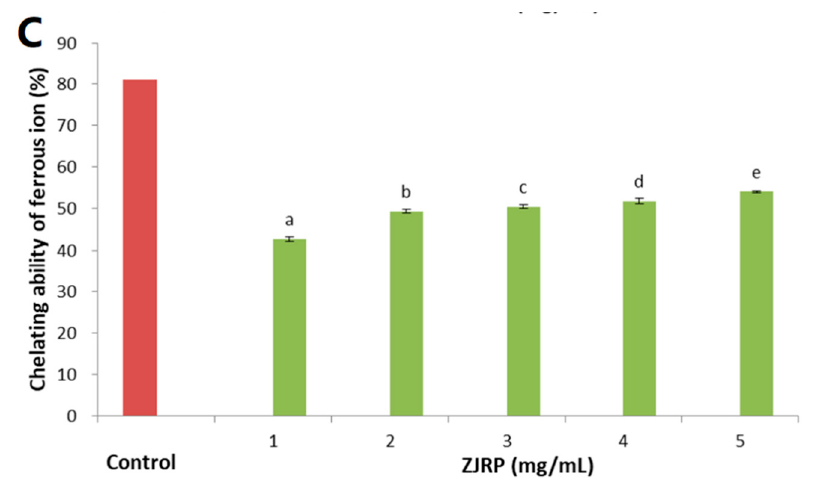
Figure 4. In vitro antioxidant capacity of ZJRP (1–5 mg / mL). ( A ) OH radical scavenging activity, ( B ) DPPH radical scavenging activity, and ( C ) chelating ability of ferrous ion. Ascorbic acid (1 mg / mL) was used as a positive control. (The di ff erent letters in the figures represent significant di ff erences from other results, P <